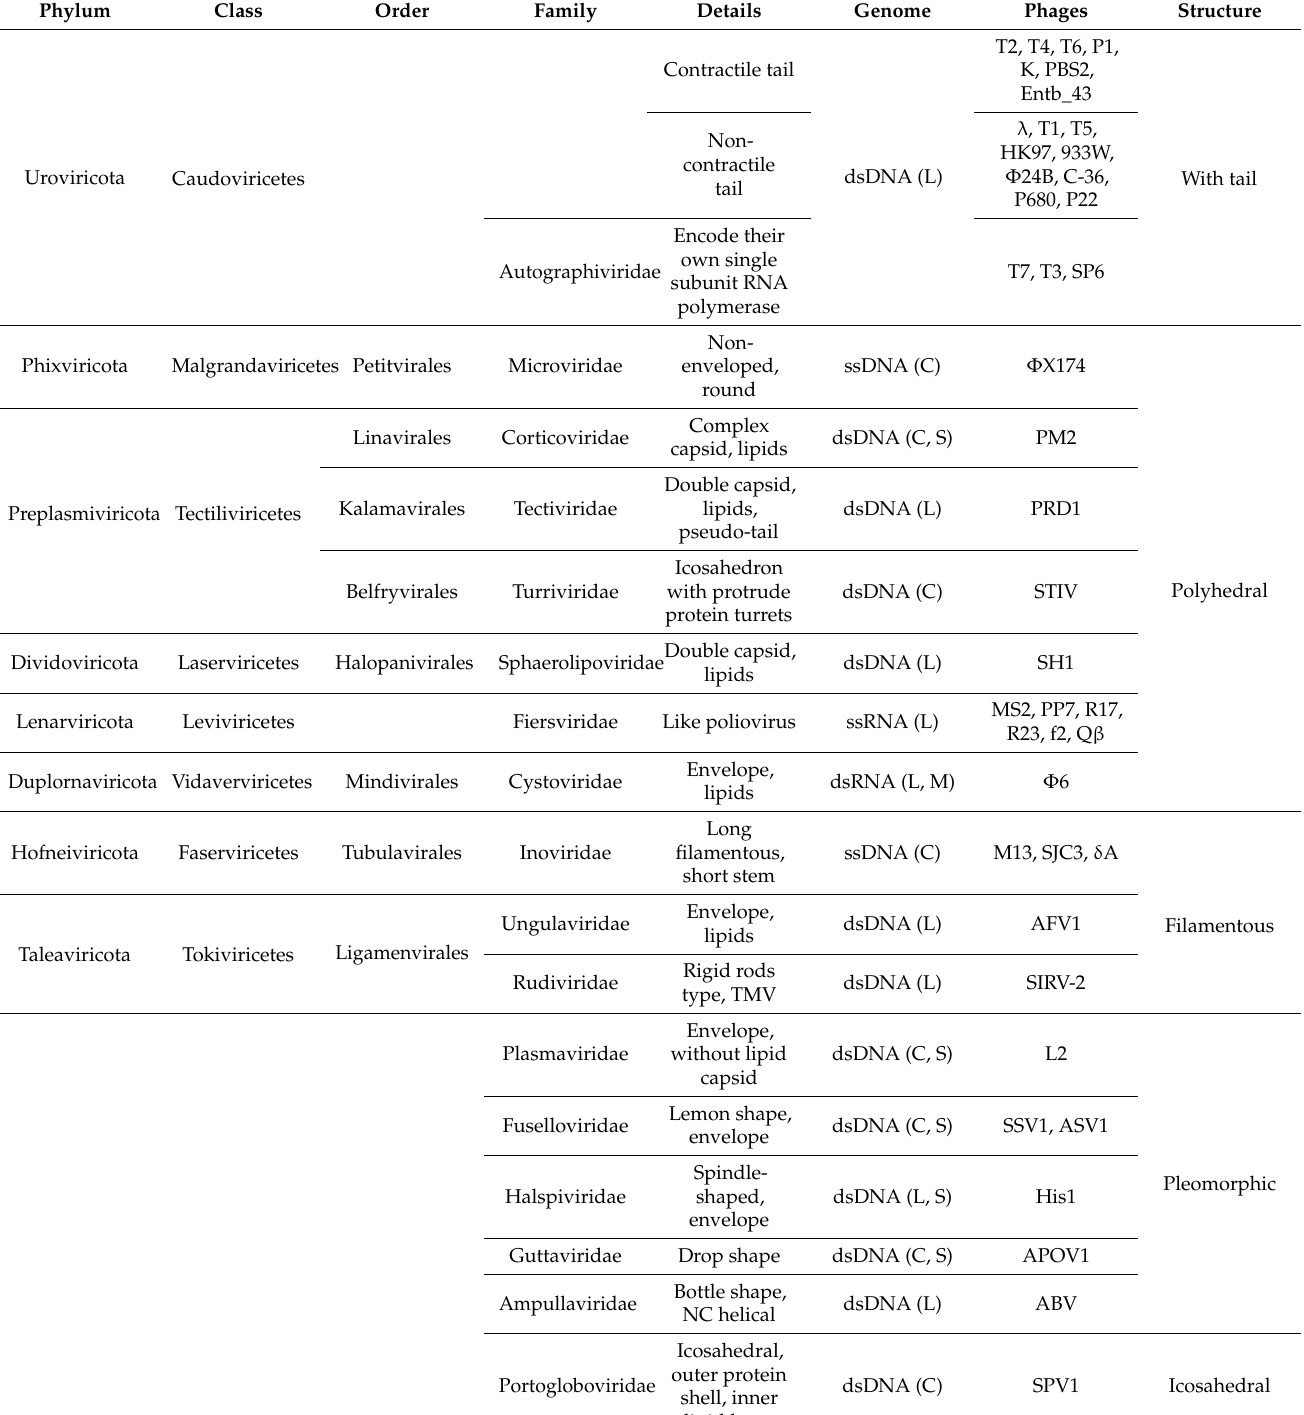
Table 1. Diversity of bacteriophages in accordance with taxonomic